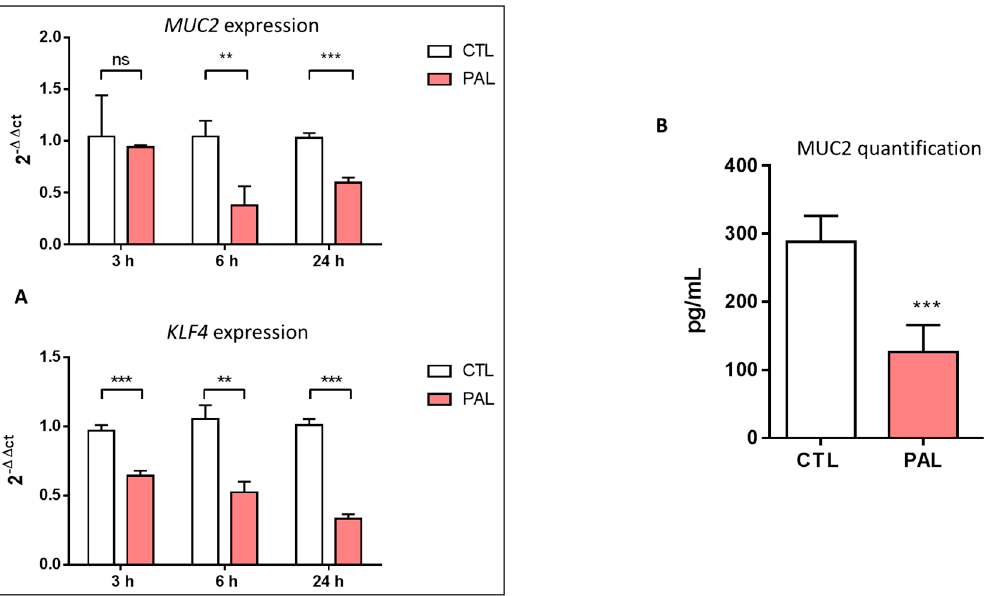
Figure 1. E ff ects of palmitic acid on MUC2 and KLF4 expressions and MUC2 production in LS174T cells. LS174T cells were incubated for 3, 6, or 24 h with PAL (300 µ M), or BSA as the control. Cells were harvested, the total mRNA was isolated, and the levels of Muc2 and KLF4 ( A ) expressions were analyzed by real-time quantitative PCR. ( B ): After 24 h of treatment of LS174T cells with PAL, Muc2 quantification was performed in cell culture supernatants by ELISA. Data are expressed as the mean ± SEM of three independent experiments. ** p < 0.01 and *** p < 0.001 versus CTL-treated groups (Student t test). ns: non-significant; CTL: control bovine serum albumin (BSA); PAL: palmitic acid.